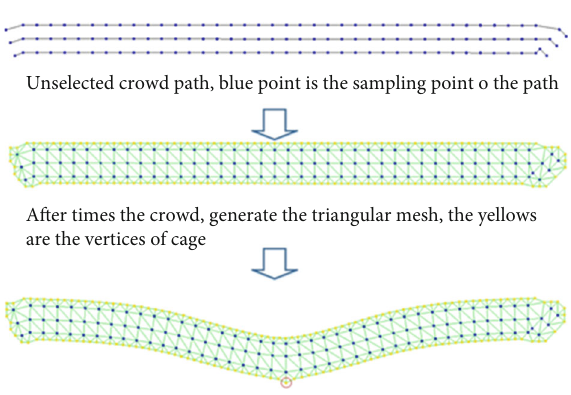
Deformation effect after dragging the vertex on the cage (the point in the red circle) Figure 4: Dragging e ff ect without fi xed concave hull after deformation. T is an m ∗ n matrix. m